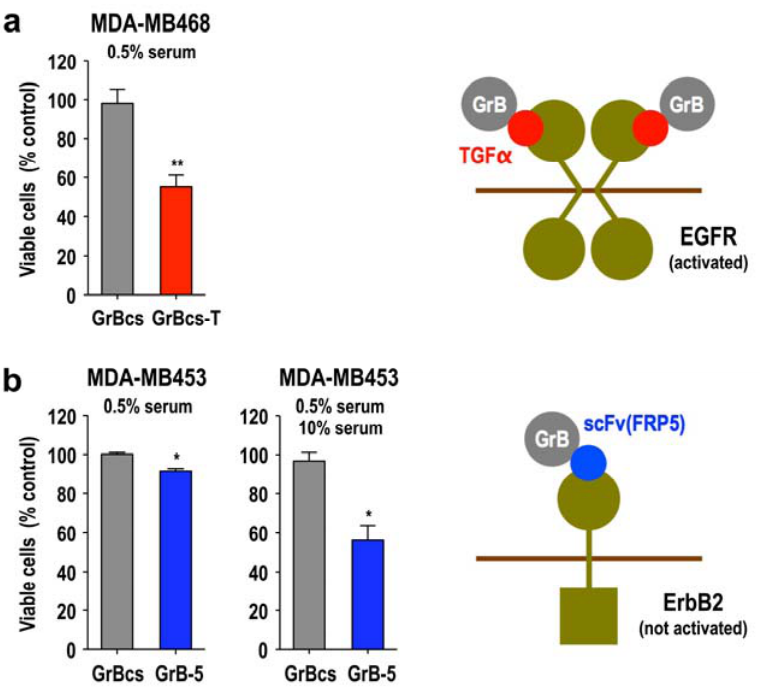
Figure 4. Cytotoxic activity of targeted GrB proteins against resting cells. ( a ) EGFR- positive MDA-MB468 breast carcinoma cells were starved for 4 h by incubation in low serum (0.5% FCS), before treatment for 24 h with 1 µg/mL (25 nM) of EGFR-specific GrBcs-T protein in the presence of 50 µM chloroquine in medium also containing 0.5% FCS. ( b ) ErbB2-positive MDA-MB453 breast carcinoma cells were starved for 4 h